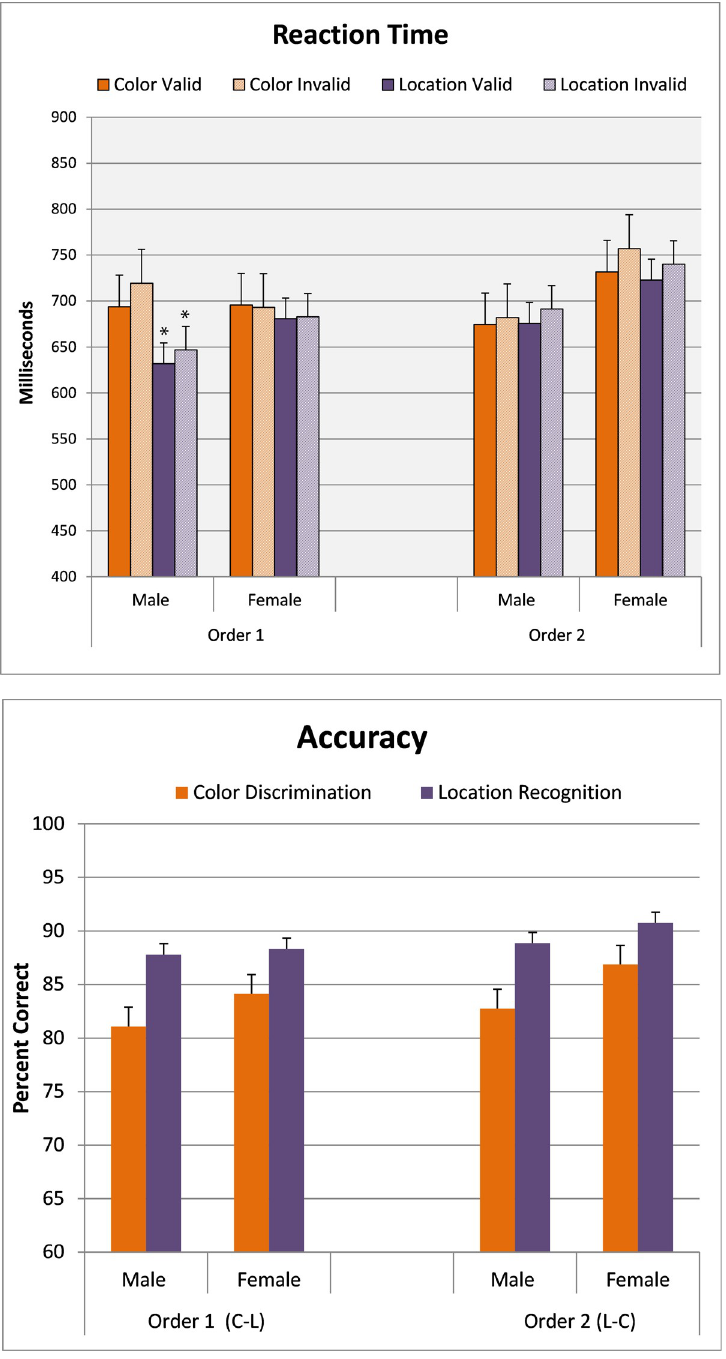
Fig 4. Influence of right/left of center for the appearnace of stimulus to match. Data shown are the mean (+ SEM) for reaction time and accuracy. Top Panel: reaction time to make a correct decision matching on color and position using a cue to predict the right/left of center appearance location of the stimulus to match. Cue was valid on 80% of the trials, but had no relationship to stimulus matching. � p < 0.05 compared to opposite sex in same order. Top Panel: Reaction time to make a correct matching decision (Yes/No) for valid and invalid trials related to the endogenous positional cue. Bottom Panel: Percent of correct answers from same participants.